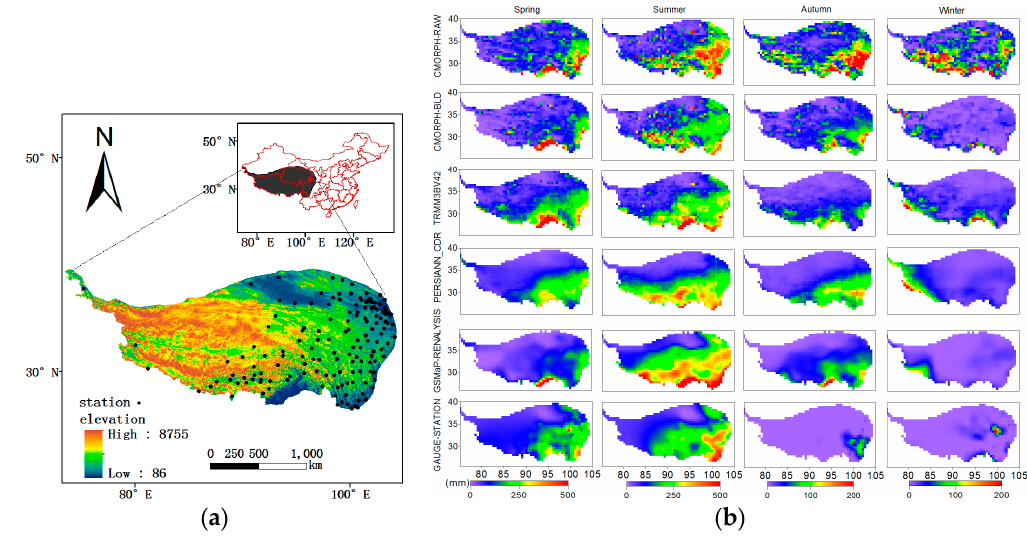
Figure 9. The precipitation distributions of the rain gauge stations ( a ) and multiple satellite ( b ) in 2013 over southern China.